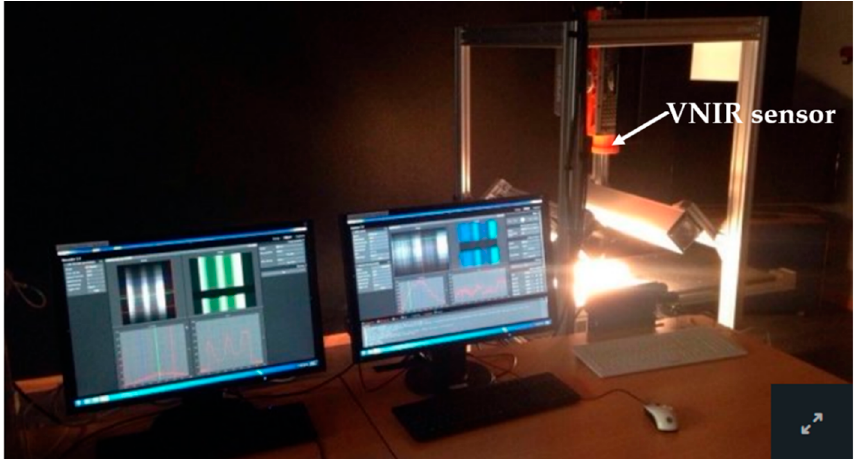
Figure 1. The experimental laboratory setup for image data collection. On the tripod in the center is the VNIR imaging spectrometer camera placed at an angle of 90°. Next to the sensor is a sliding table where the soil tray is placed for scanning. On the right and the left side of the sliding table, an external light source is integrated to illuminate the tray during image acquisition.